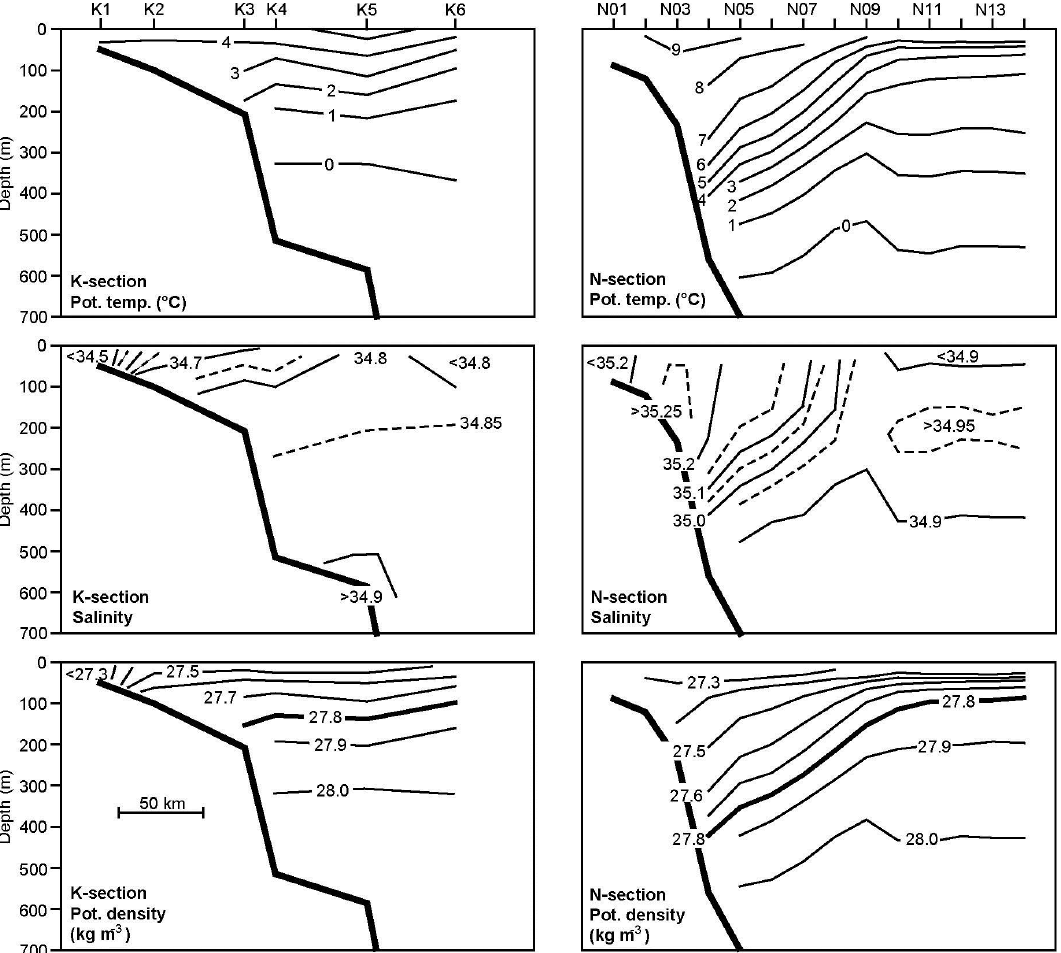
Figure 6. Average hydrographic properties in the two sections 1996–2012, based on 59 cruises at the K-section (only 46 at K6) and 51 cruises at the N-section. The horizontal scale is equal for all the panels and is shown in the bottom left